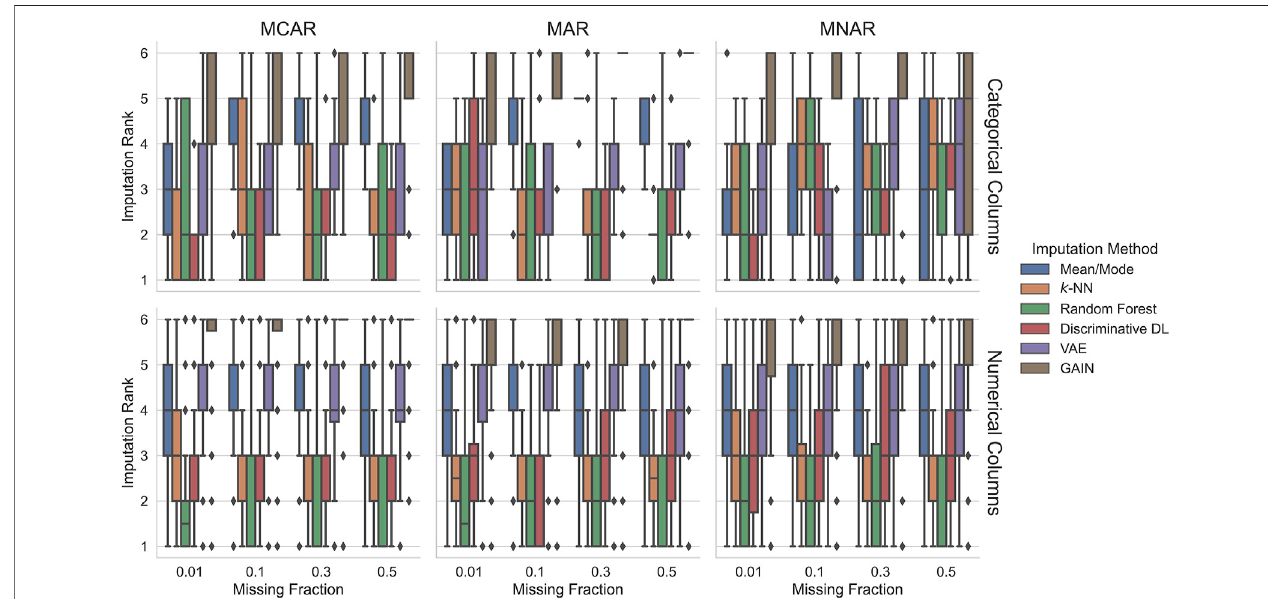
FIGURE 1 | Imputation ranks of the imputation methods trained on complete data. Ranks are computed for each experimental condition characterized by the dataset, missingness pattern, and missingness ratio. Since we compare six imputation methods, the possible imputation ranks range between 1 and 6. In most conditions,randomforest, k -NN,anddiscriminativeDLperformbest.Generativedeeplearningmethodstendtoperformworst.InthemostchallengingMNARcondition, mean/mode imputation achieves competitive results.